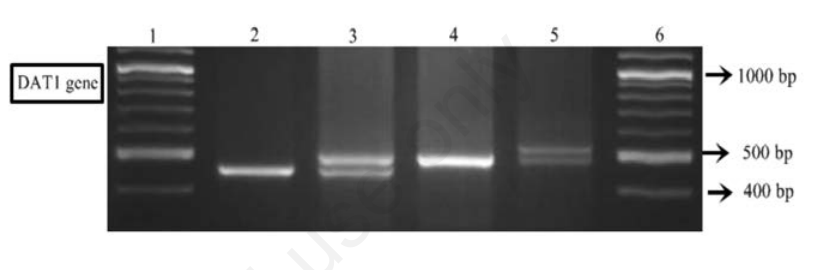
Figure 1. Electrophoregram of the Genescan Analysis of the DAT1 repeat polymorphism. The Genescan™ data represents a heterozygous DAT1 gene with VNTR sizes 435 bp and 475 bp (black arrow).